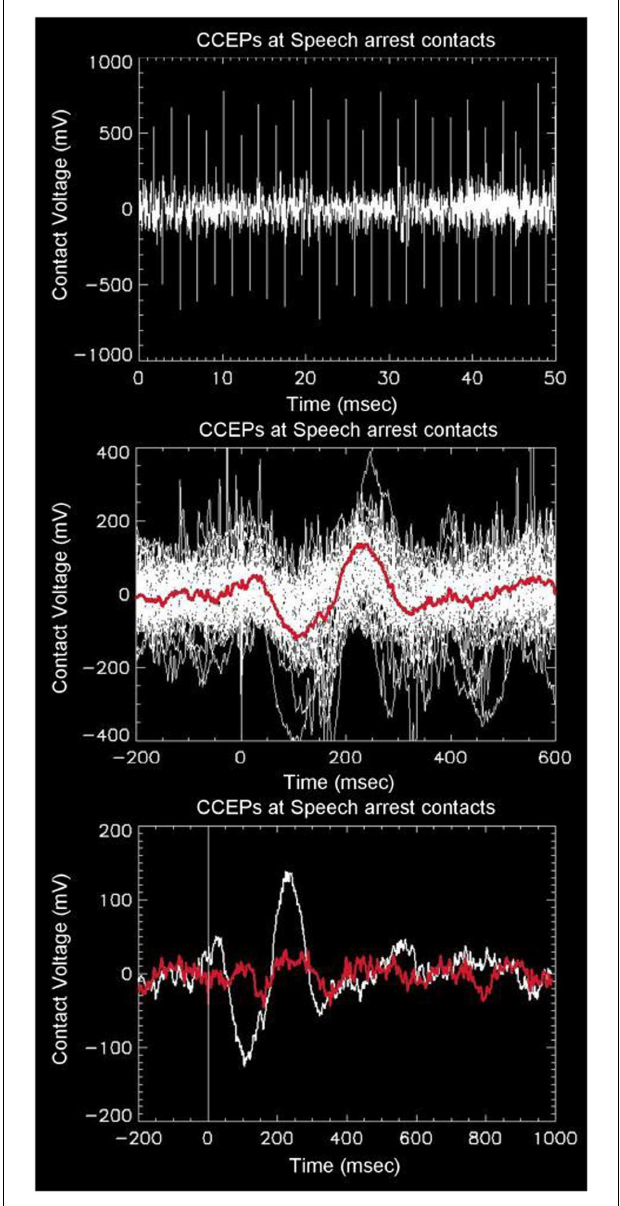
FIGURE 1 |Top: example of raw data recorded from one intracranial electrode (in this case overlaying the presumedWernicke’s area in the left angular gyrus) in response to stimulation from left Broca’s region . There are a total of 46 alternating unipolar stimulations seen as spikes from stimulation artifact.The middle panel shows the overlay of all 46 waveforms as referenced to a common stimulation time.The red line shows the average of the waveforms, with a prominent downward peak at 100ms, followed by an upward peak at 230ms.The bottom panel shows the same average waveform overlaid with the waveform obtained from one adjacent electrode 10mm away, showing strong spatial variability from distal